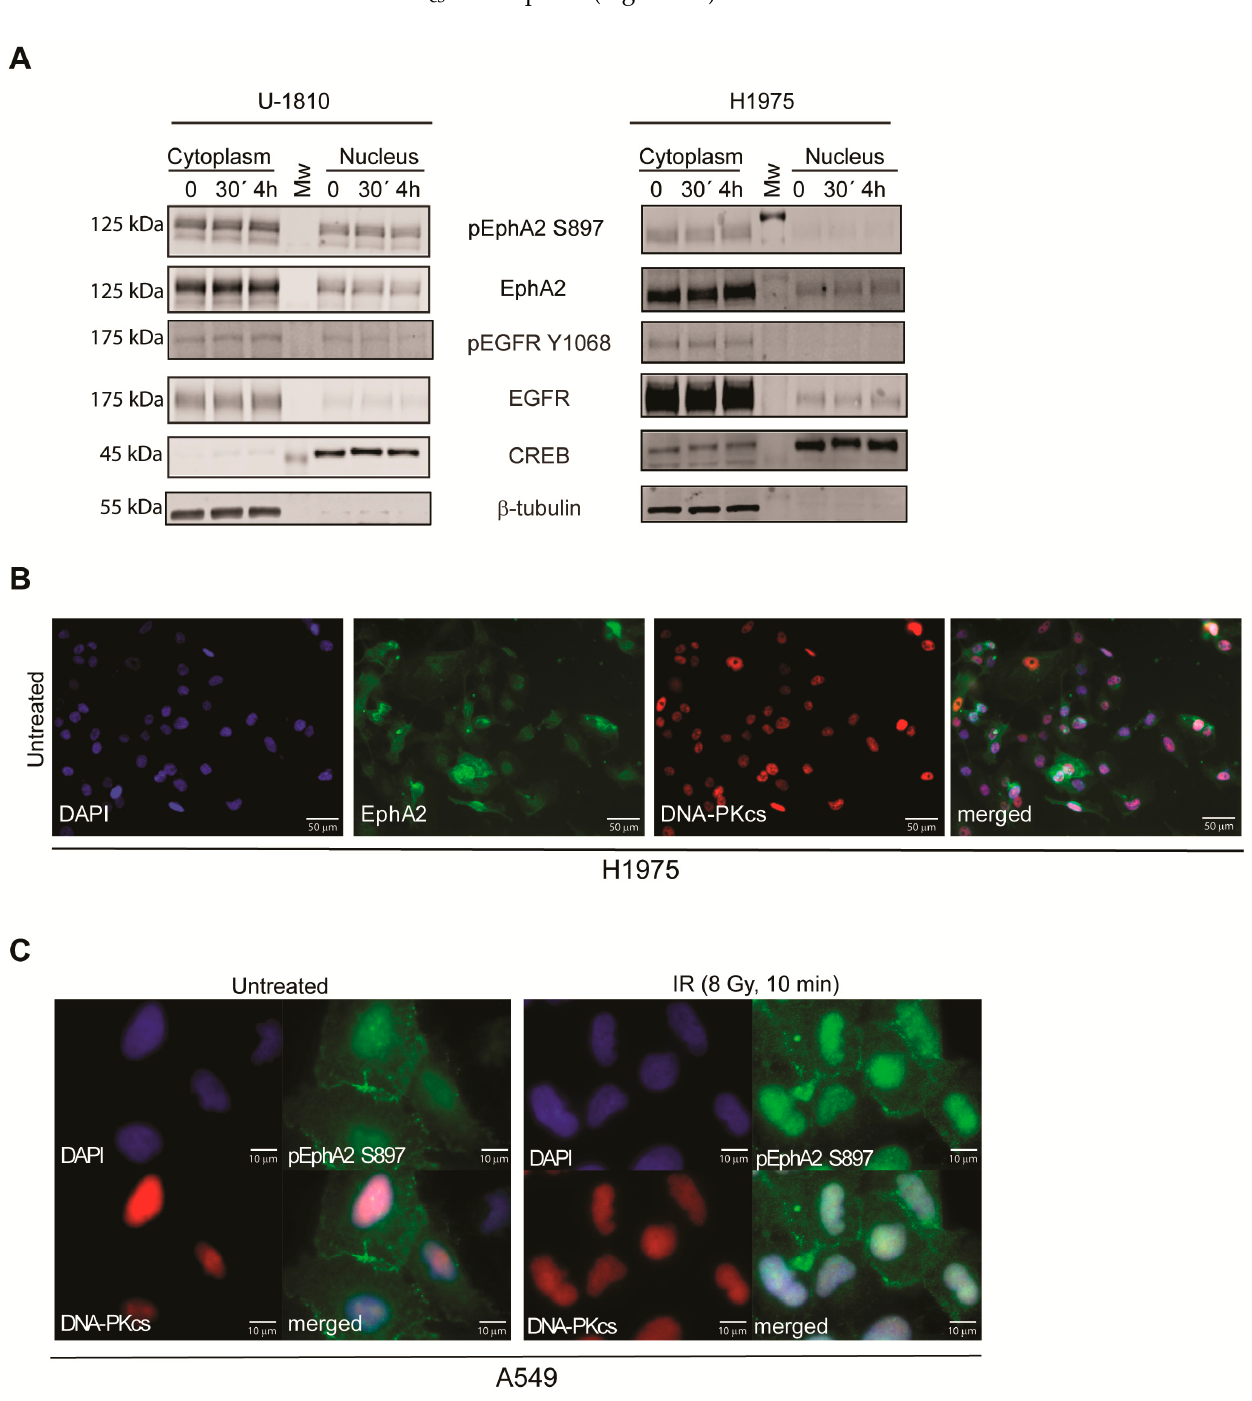
of DNA-PK cs with EphA2 (Figure 4C).